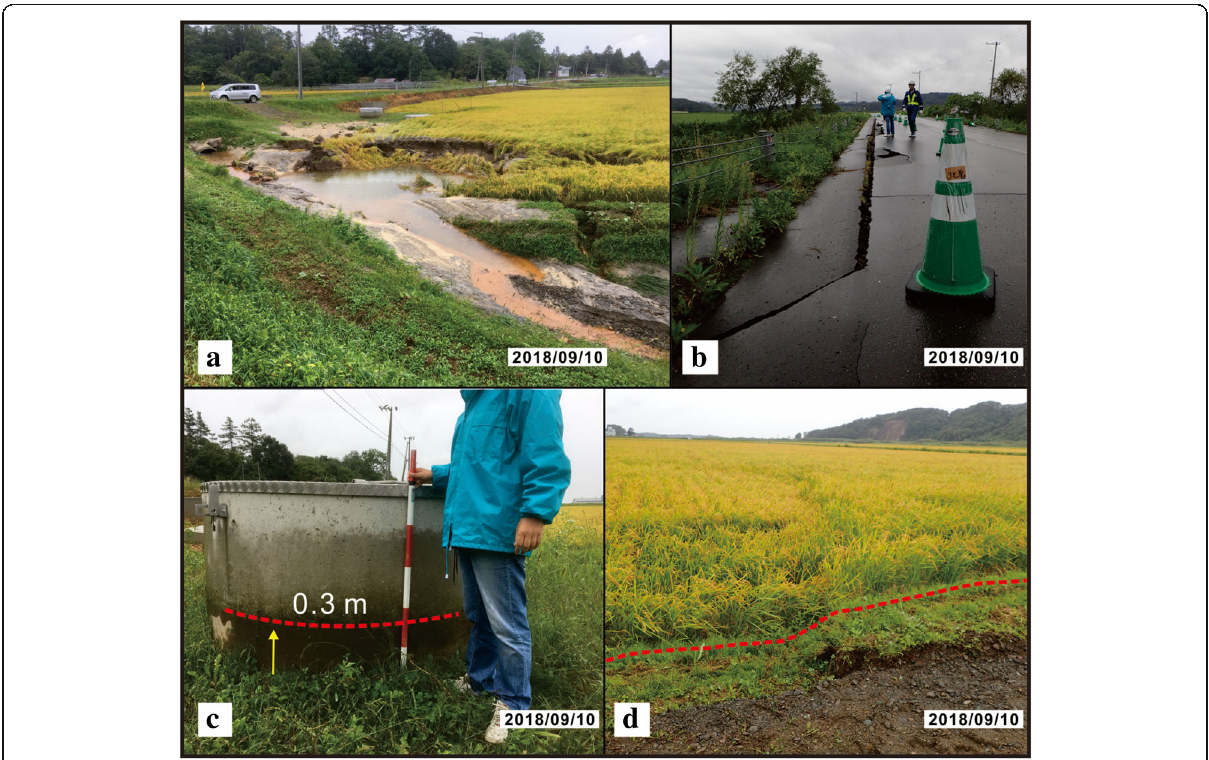
Fig. 3 Damages and liquefactions resulted from the Iburi earthquake sequence. a Liquefaction and jetted sand in the paddy field. b Road damage. c Uplift of inlet well. d Surface rupture in the paddy